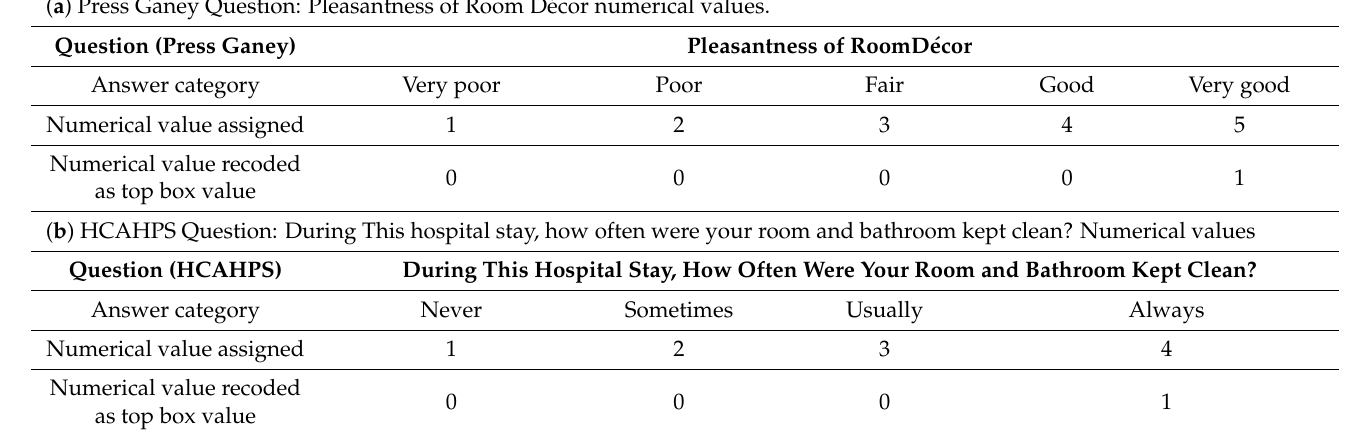
Table 2. Listing of Press Gainey and HCAHPS survey example questions with full-scale numerical